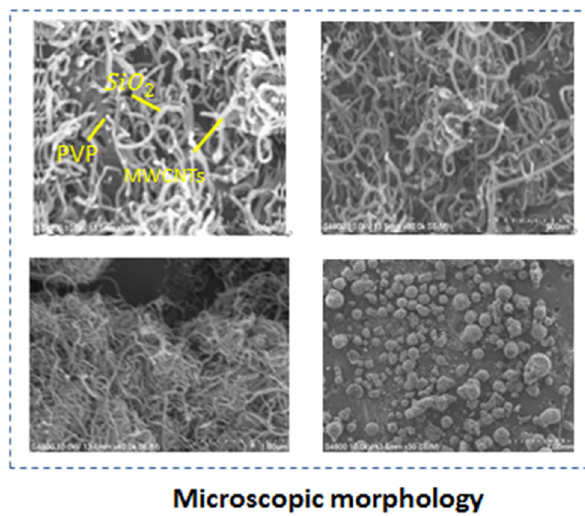
Figure 4: Scanning electron microscopic imaging of MWCNTs – SiO 2